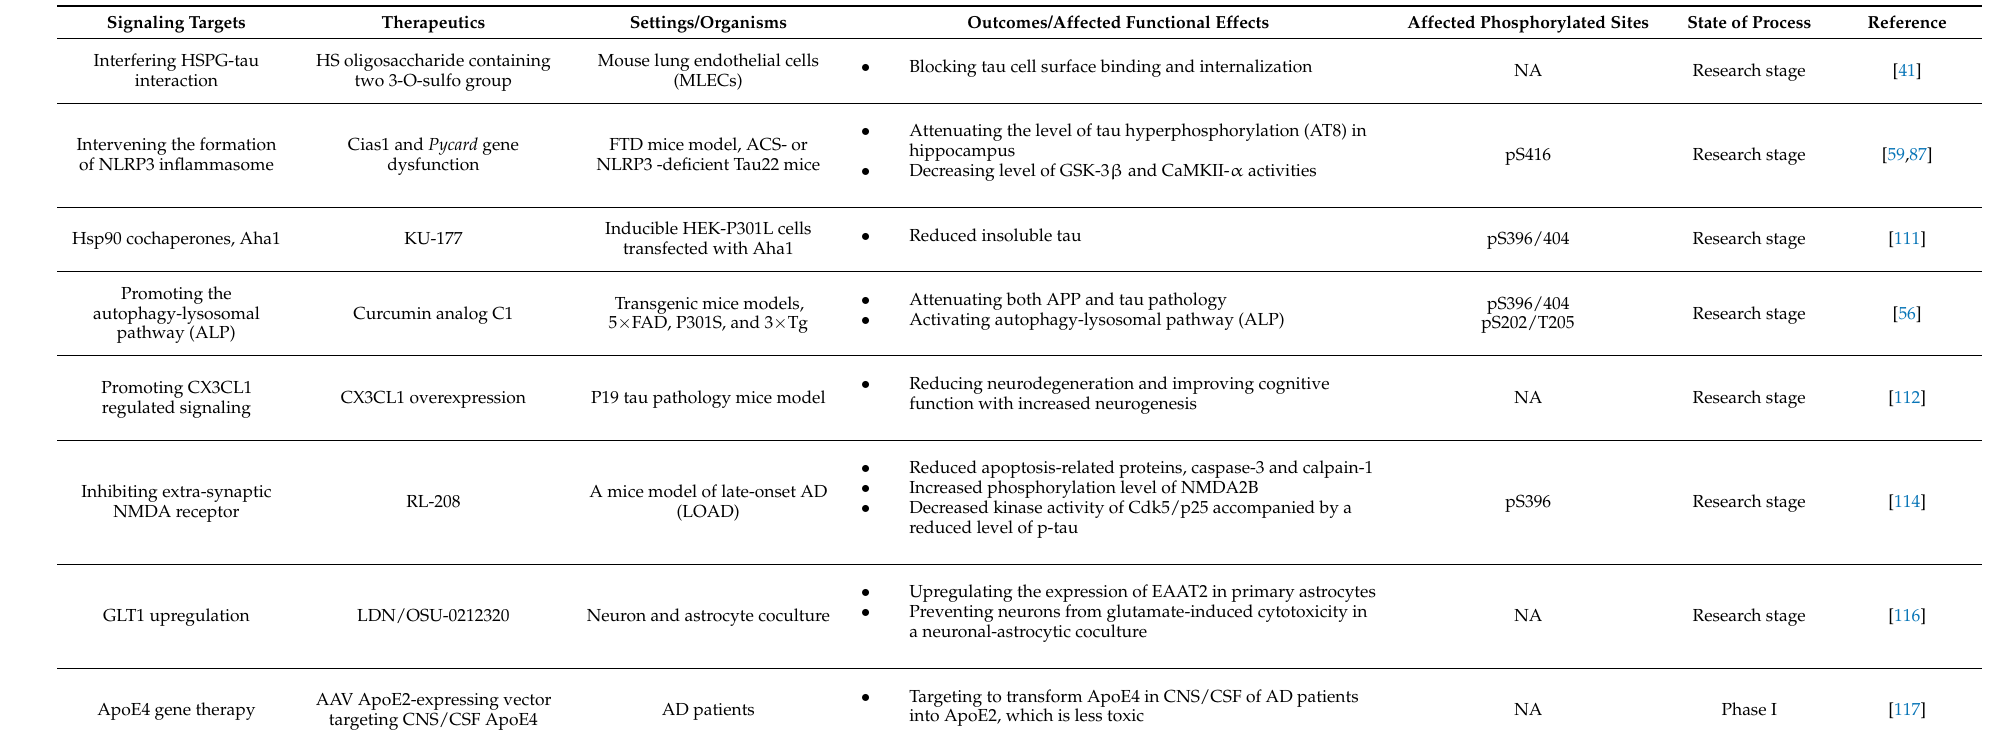
Table 3. Potential therapeutic targets for the treatment of